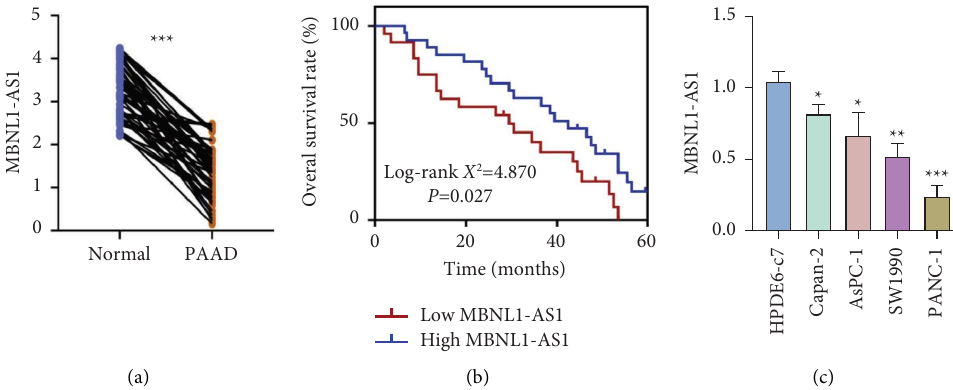
Figure 1: MBNL1-AS1 was downregulated in PAAD and closely related to PAAD progression: (a) MBNL1-AS1 expression in PAAD tumor tissues and adjacent normal tissues. (b) Te overall survival rate of PAAD patients with high MBNL1-AS1 expression or low MBNL1-AS1 expression. (c) MBNL1-AS1 expression in the normal pancreatic ductal epithelial cells (HPDE6-C7) and PAAD cell lines (capan-2, AsPC-1, Table 1: Relationship between MBNL1-AS1 and clinicopathological characteristics of PAAD.